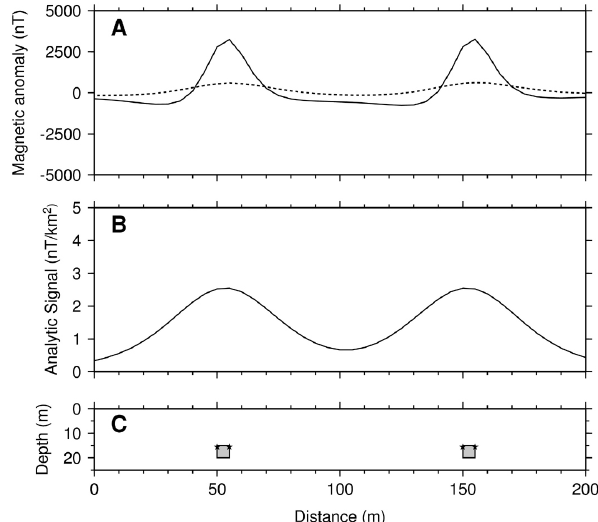
Fig. 5. (a) The solid line indicates the magnetic anomaly calculated from the two prisms shown in (c) , and the dashed line indicates the upward continuation of the anomaly at 20m; (b) analytic signal of (a) ; and (c) test model consisting of two prisms with dimensions of 5m × 5m. Black stars indicate the calculated depths for the